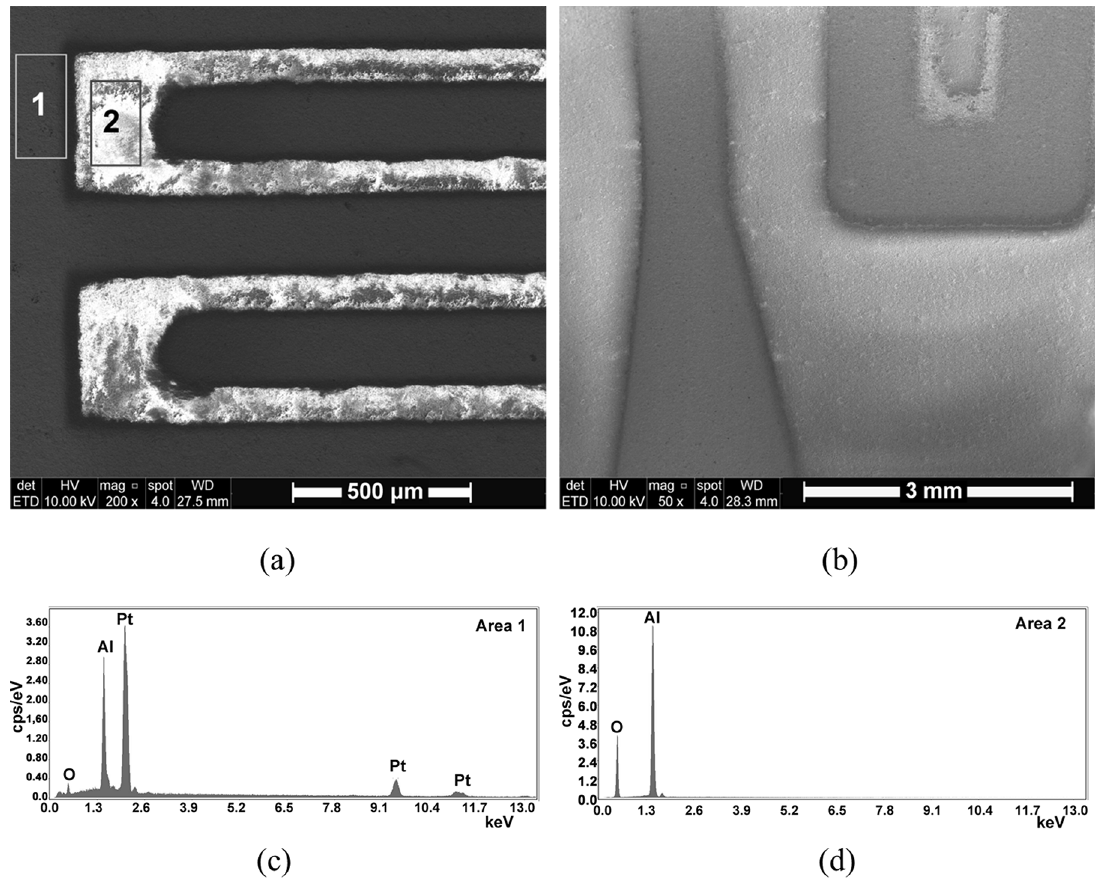
Figure 5. Sensor surface analysis for a) FESEM of the S1B electrode, b) FESEM of the S2A heater, c) EDX spectrum of the S1B electrode (point 1), d) EDX spectrum of the S1B electrode (point 2), e) FESEM of the SnO film of sensor S1A. 2 10 V voltage at 80 ºC. Electrical resistance varied significantly for all the sensors, which detected CH at all the levels 4